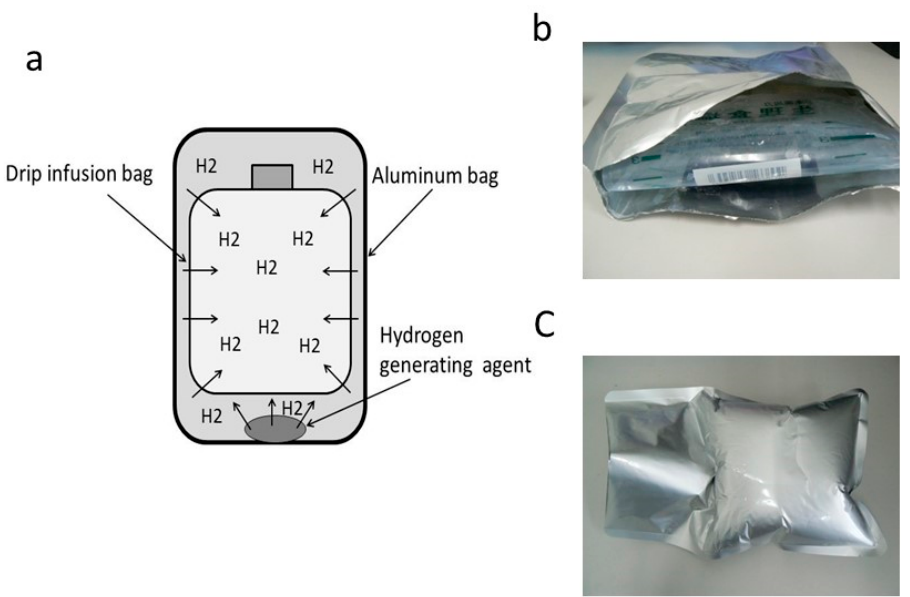
Figure 3. ( a – c ) Device for hydrogen (H 2 )-rich saline. ( a , b ) Non-woven fabric containing H 2 -generating agent was moistened with a small amount of water, and both the drip infusion bag and the non-woven fabric were wrapped in aluminum foil and vacuumed. ( c ) The H 2 -generating agent in the non-woven fabric reacted with water to produce H 2 , and the H 2 gas permeated the polyethylene film inside the bag and dissolved aseptically into the saline.